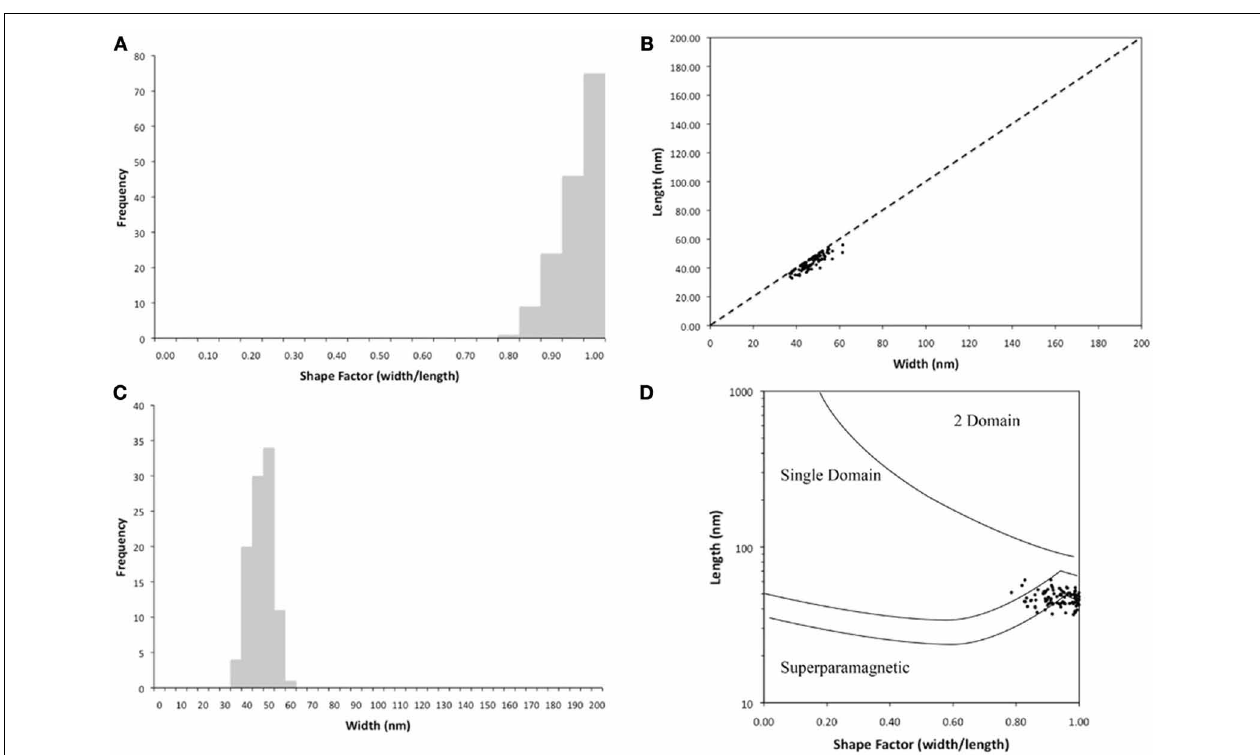
FIGURE 4 | Characterization of the magnetosomes contained within the magnetotactic bacteria that were isolated from Pavilion Lake. (A) Frequency of the shape factor demonstrating that the crystals are nearly equal in width and length. (B) Width measurements of the magnetosomes